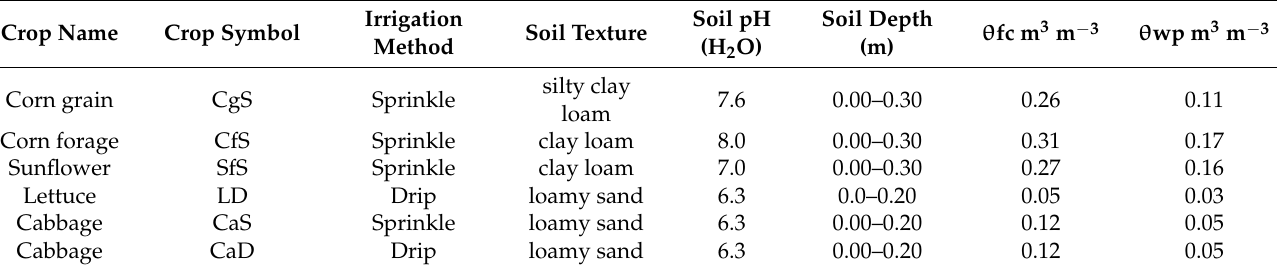
Table 3. Other irrigated crops—irrigation method and soil properties.